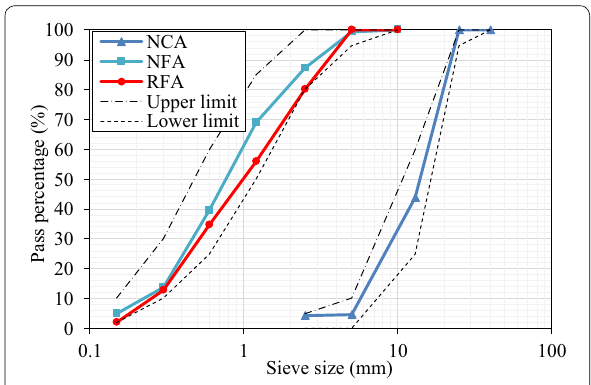
Fig. 1 Particle size distribution curve for NCA, NFA, and